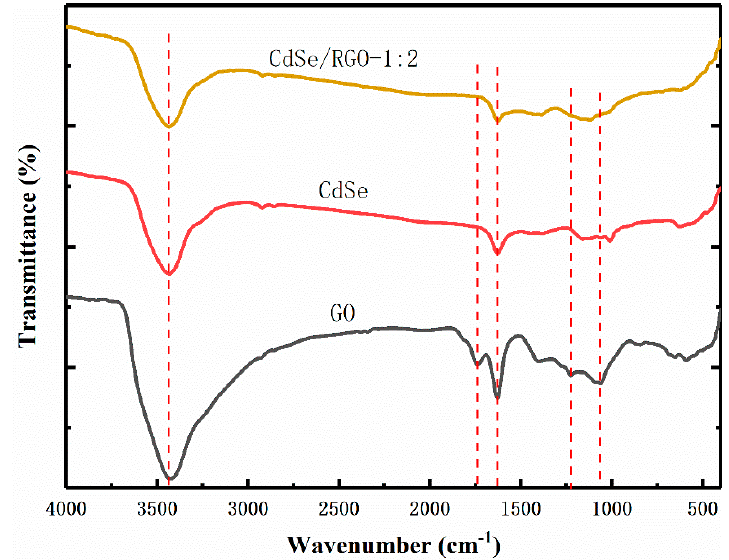
Figure 6. FT-IR spectra of GO, CdSe and CdSe/RGO-1:2 composite materials.